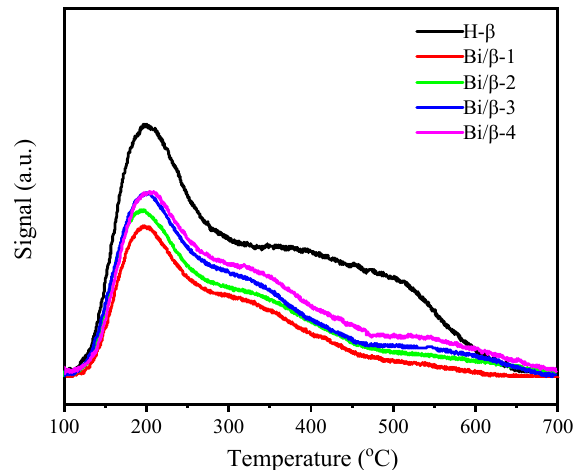
Figure 6. NH 3 -TPD profiles of H/ β and various Bi/ β catalysts with different Bi loading.